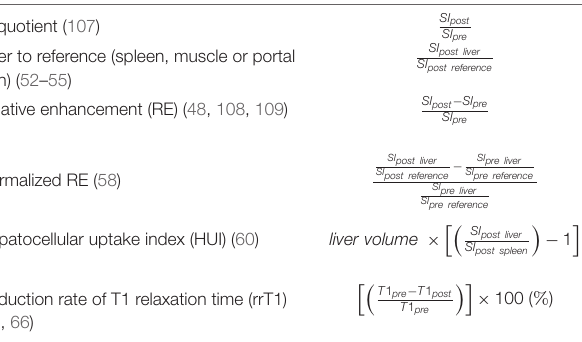
TABLE 2 | Summary of equations for assessing liver function.